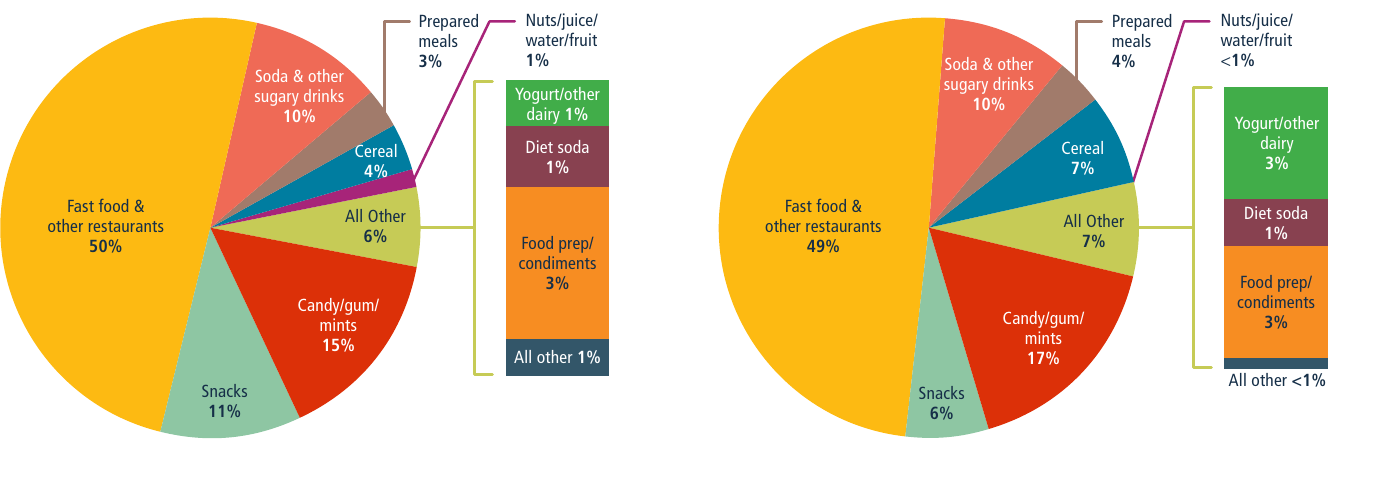
Source: Rudd Center analysis of Nielsen data (2018)* Analysis of advertising spending by the 236 highly advertised brands included in this analysis